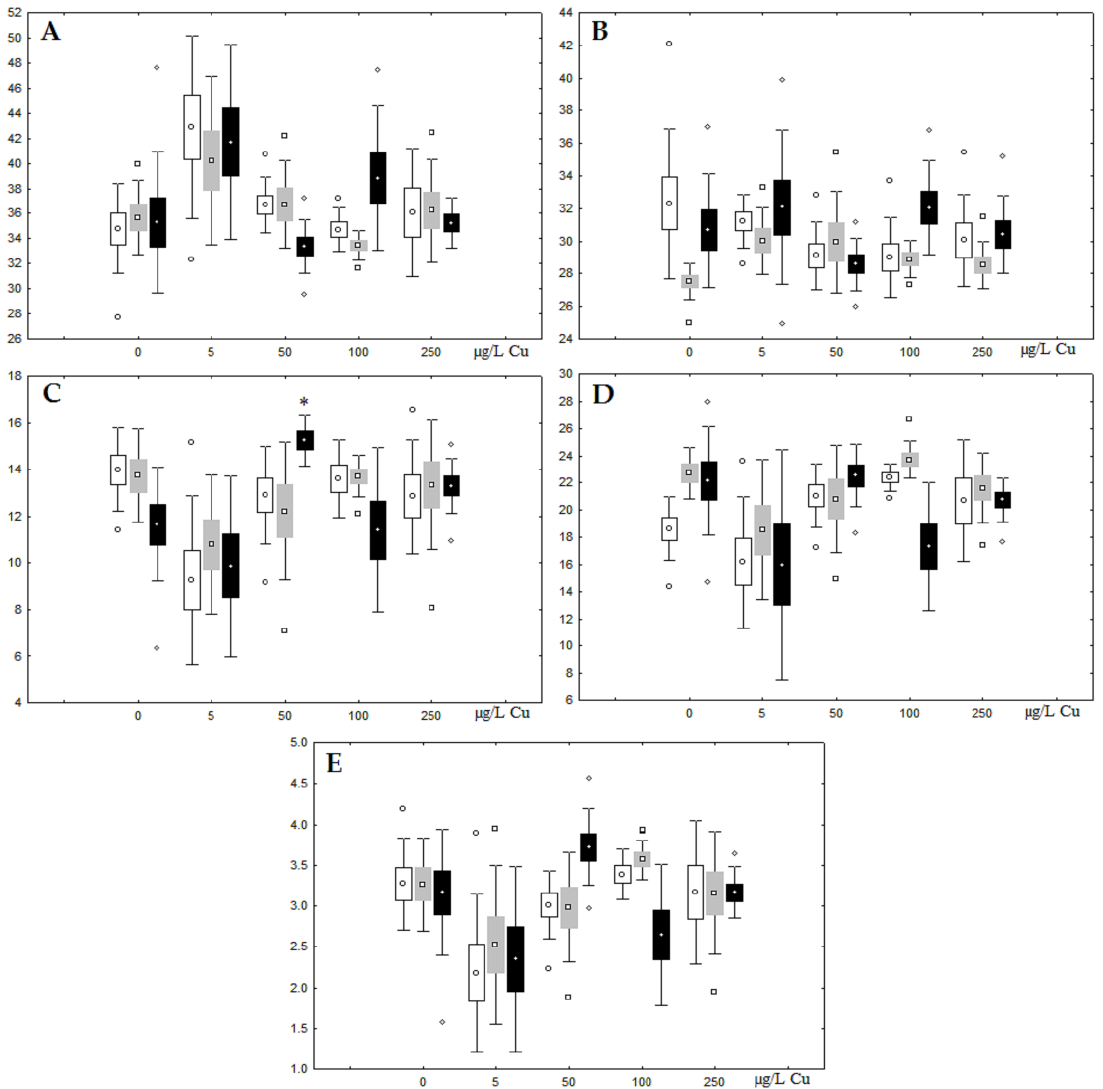
Figure 9. Changes in the ( A ) sum of saturated fatty acids, ( B ) monounsaturated fatty acids, ( C ) n-3 polyunsaturated fatty acids, ( D ) n-6 polyunsaturated fatty acids, and ( E ) unsaturation index in triacylglycerols of digestive glands of A. cygnea under experimental copper effects: white box—day 1 of the experiment; grey box—day 3 of the experiment; black box—day 7 of the experiment. *—significant results in comparison with control (0 µg/L Cu). Differences were estimated using the nonparametric Kruskal–Wallis test; p < 0.05.